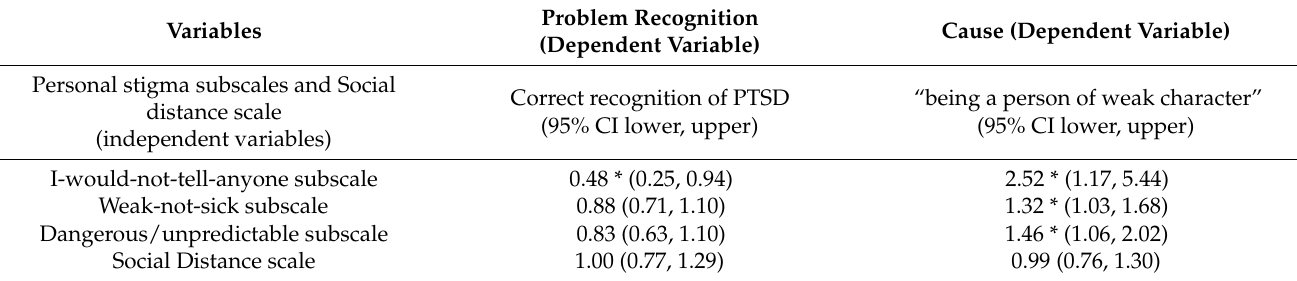
Table 4. Odds ratios of eight logistic regression analyses of predictors of correct recognition of PTSD and endorsement of a cause as “likely”, adjusted for age and